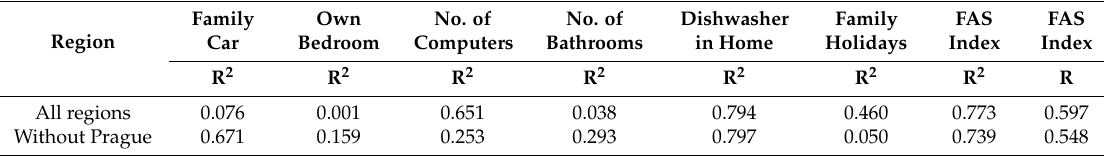
Table 4. Index of determination (R 2 ) for individual questions.